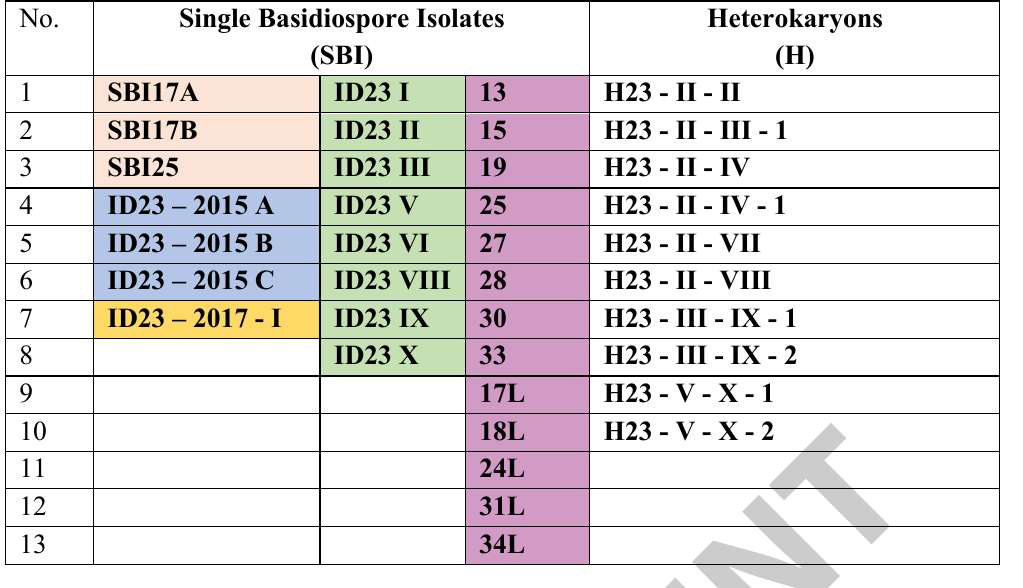
Table 1. List of tested R. solani strains (various colors indicate SBIs obtained in separat e cycles of sexual